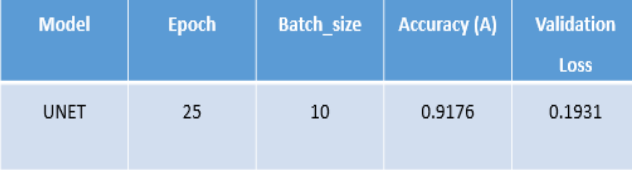
Tab.3 : Overall Summary on Test Data.